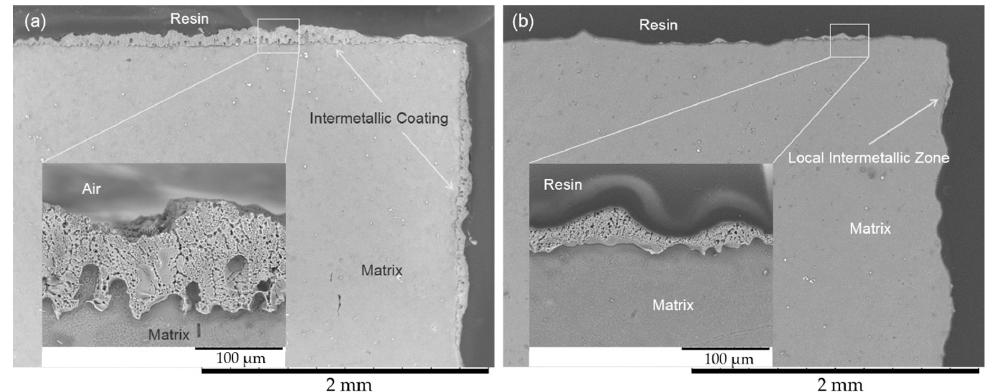
Figure 10. ( a ) The as-di ff usion alloyed intermetallic layer obtained with 1 g of NH 4 Cl, 10 g of Al powder 10 and 10 g of Al 2 O 3 powder as the di ff usion source; ( b ) The intermetallic layer on the specimen which not only underwent the di ff usion alloying process in ( a ) but also underwent another heat treatment at 430 ◦ C for 2 h with 20 g of SiO 2 and 3 g of NH 4 Cl in the di ff usion source